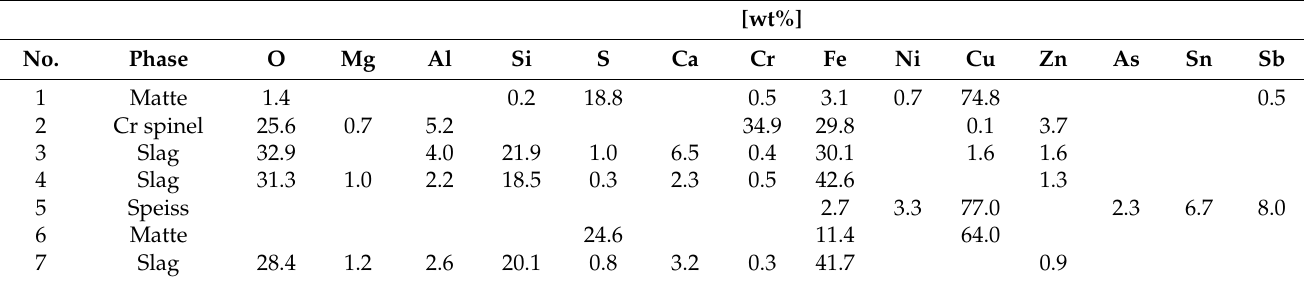
Table 6. Normalized EDS point analysis of samples collected at the settling end for T1 and settling start for T4.